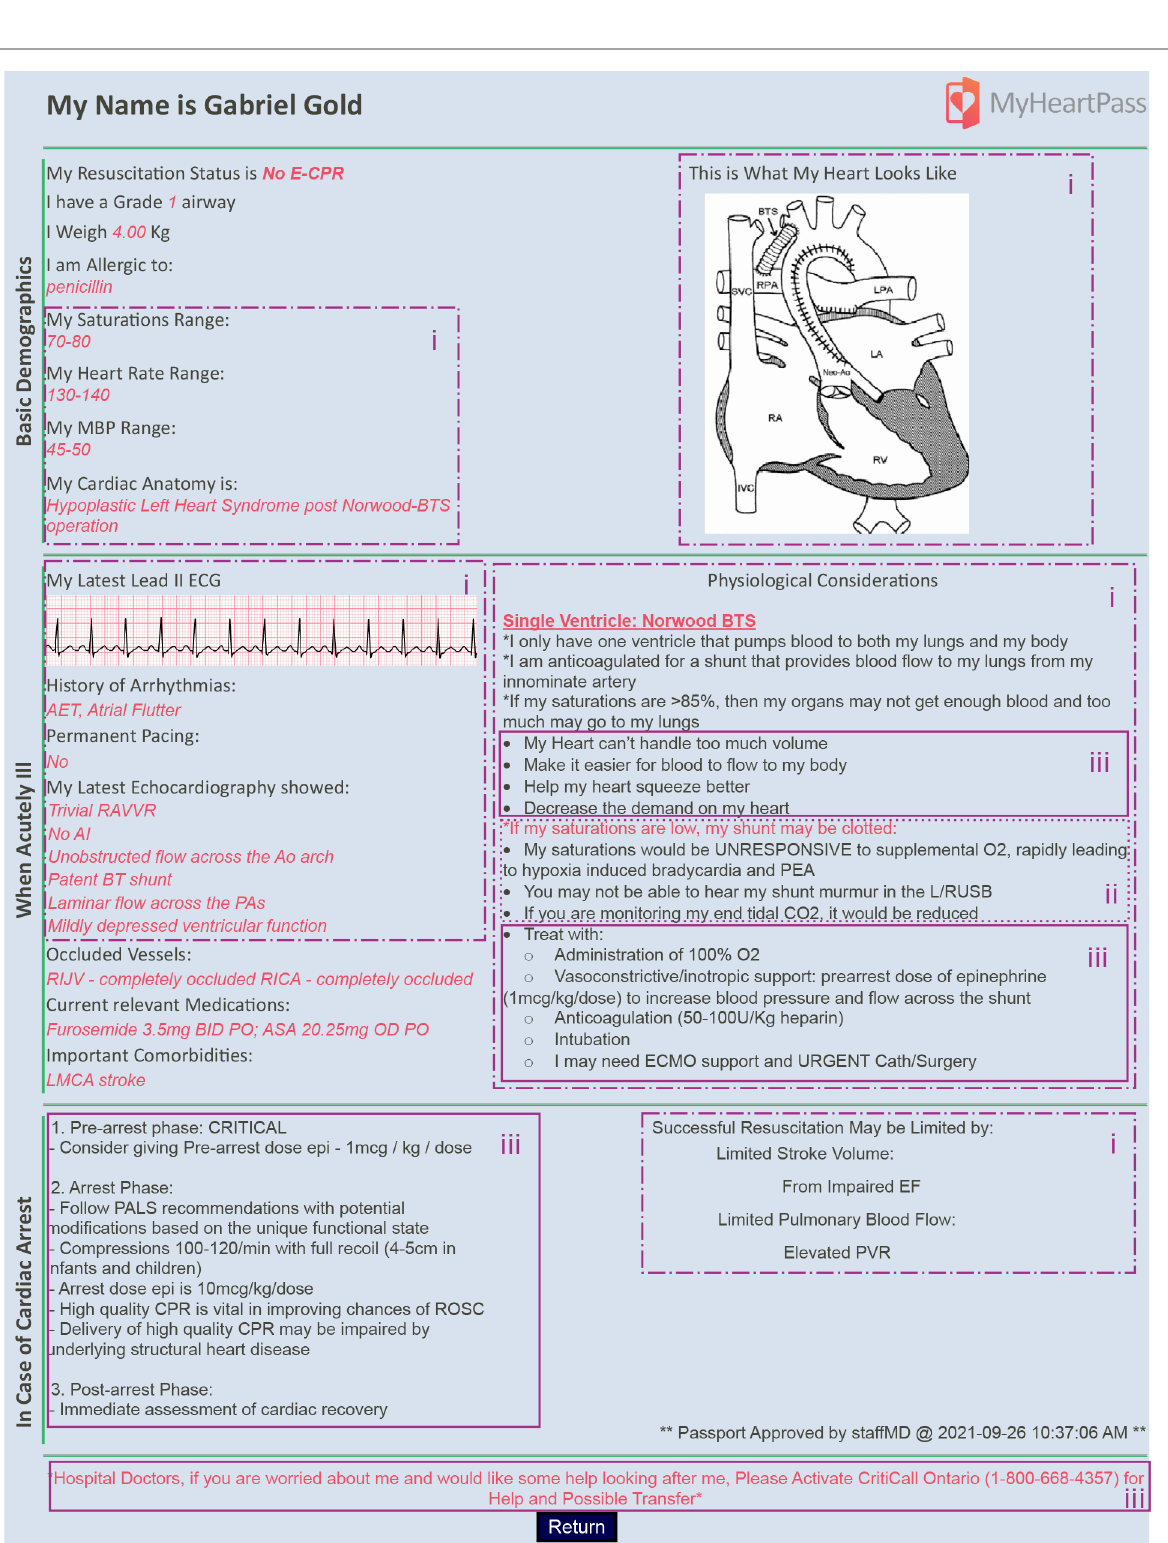
FIGURE 1 Screenshot of MyHeartPass ™ prototype. Sections marked with (i) refer to elements of design pertaining to key decision requirement distinguish the patient ’ s unique physiology based on their unique cardiac anatomy. Elements marked with (ii) capture the elements pertaining to the key decision requirement of explicitly consider CHD speci fi c differential diagnoses to allow a more structured re fl ection of diagnosis; and (iii) capture the elements pertaining to the key decision requirement of select CHD appropriate interventions for each patient